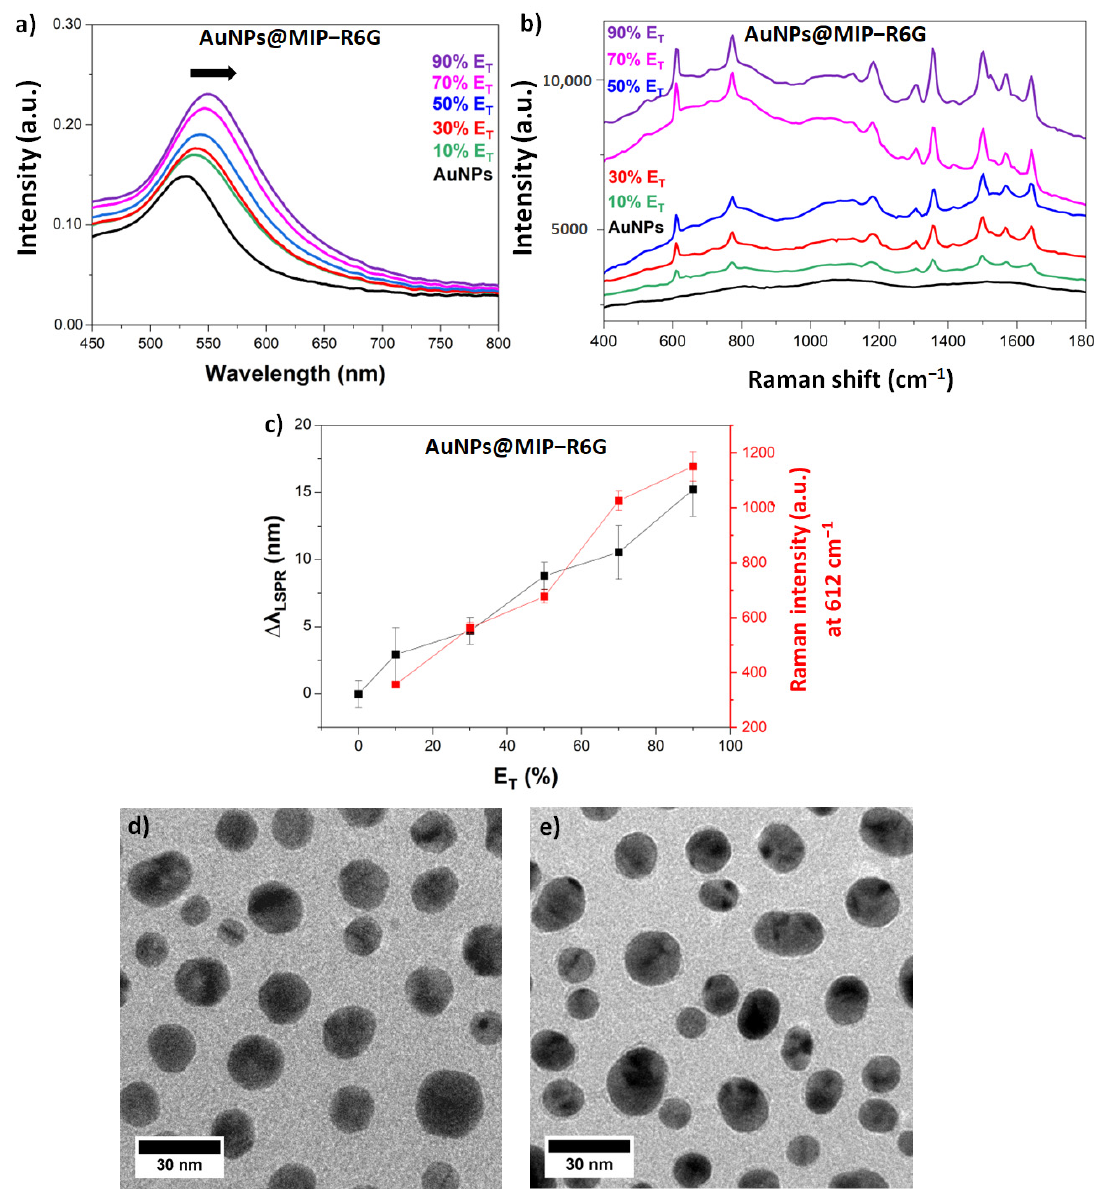
Figure 3. Monitoring of photopolymerization in ONF by ( a ) UV-vis spectrometry and ( b ) SERS; ( c ): Plot of LSPR band shift and SERS signal intensity increase from R6G to 612 cm − 1 as a function of threshold energy (E T %), TEM images of AuNPs before ( d ) and after ( e ) irradiation at 90% E T . After the synthesis of AuNPs@MIP-R6G, the functionalized NPs were rinsed accord-